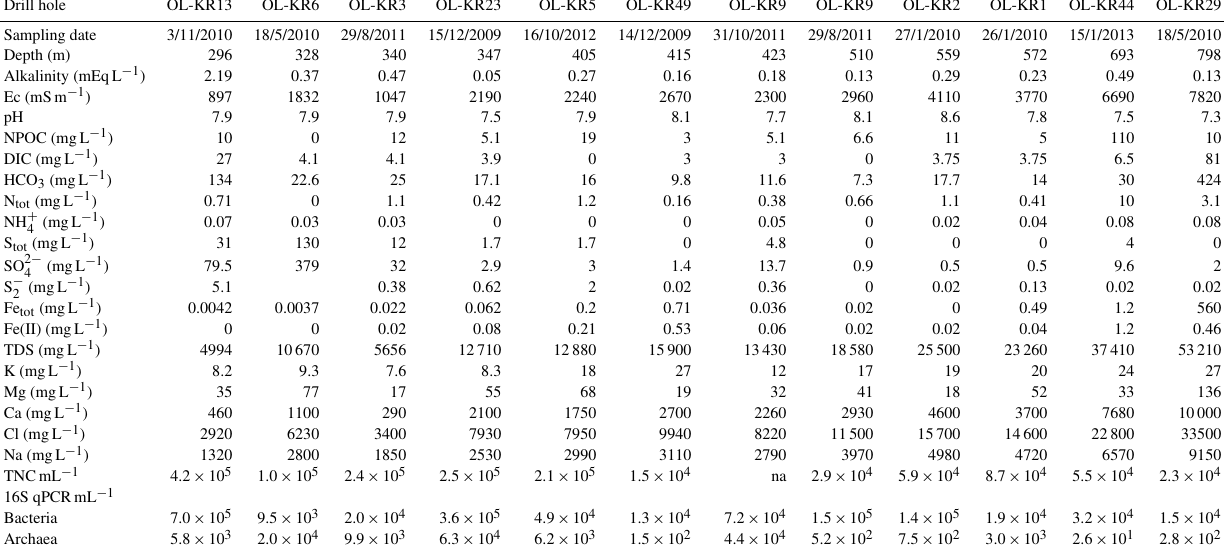
Table 1. Geochemical and microbiological measurements from 12 different water conductive fractures in the bedrock of Olkiluoto, Finland. The different drill holes are presented at the top of the table. The data are compiled from Posiva (2013) and Miettinen et al. (2015). NPOC: non-purgeable organic carbon; DIC: dissolved inorganic carbon; TDS: total dissolved solids; TNC: total number of cells. Drill